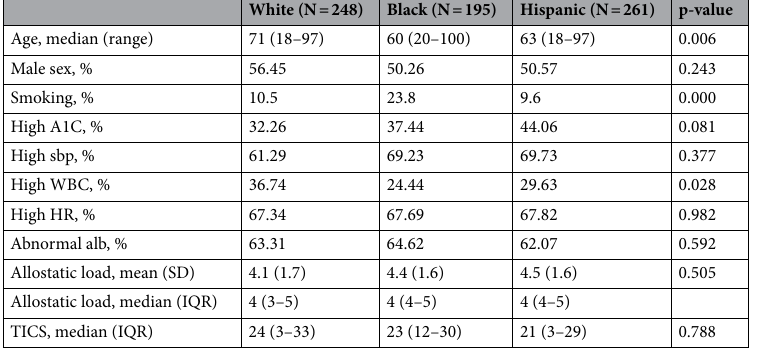
(Table 2). Adjusting for ICH severity using the ICH Score did not significantly change the results .